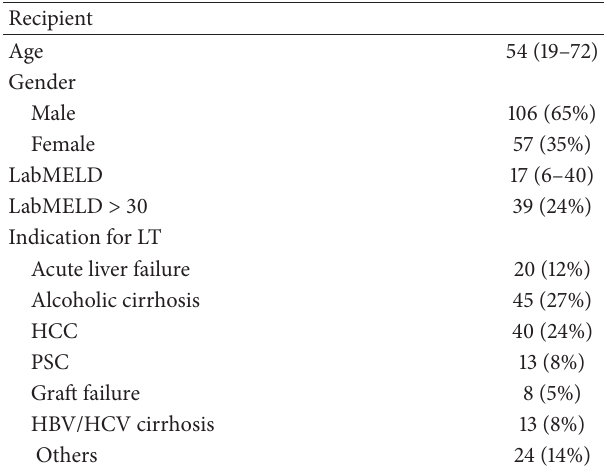
Table 1: Recipient characteristics.